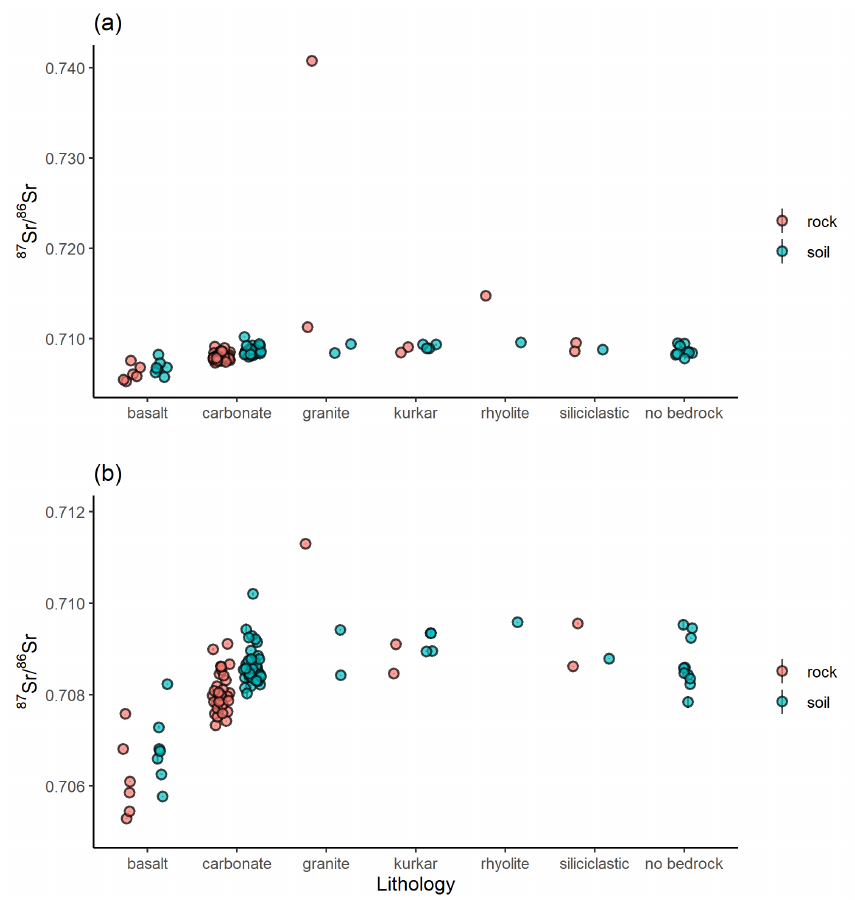
Figure 4. Bioavailable 87 Sr / 86 Sr of rock and soil samples in Israel, grouped by gross lithology observed in the field. Points indicate individual samples. (a) All data, (b) subset of data with the two highest 87 Sr / 86 Sr ratio samples, one each from the granite (site IS044) and rhyolite (site IS047) lithologies, removed to better display variability between other